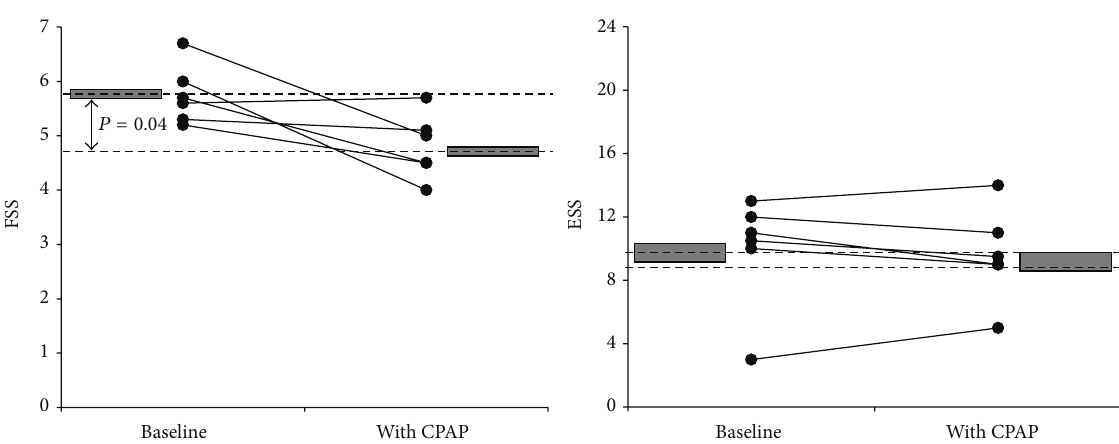
Figure 2: Follow-up under long-term treatment with continuous positive air pressure (CPAP) reveals significant reduction of FSS scores but not of ESS